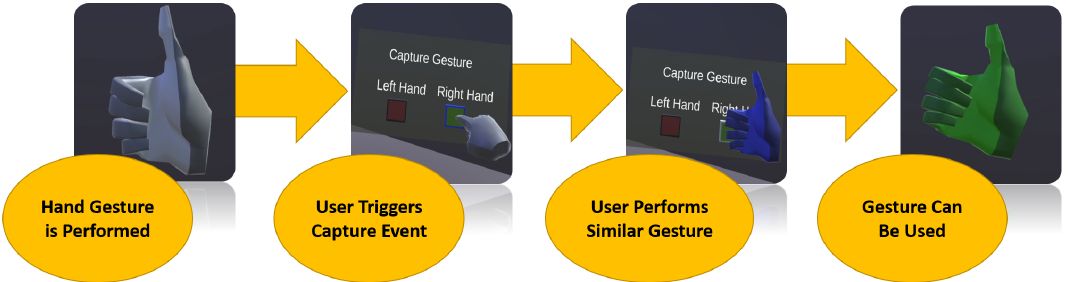
Figure 2. The user of the system can capture and test gestures for later use. In the depicted case, a button is pressed to start gesture capturing, the user then has a certain amount of time to perform the desired gesture. After capturing, the gesture can be used within the virtual